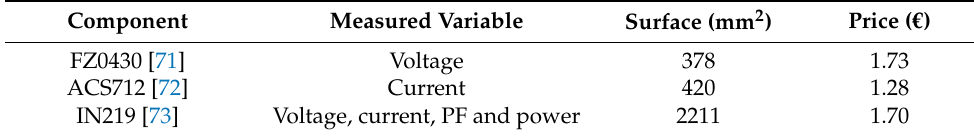
Table 4. Comparison of electrical